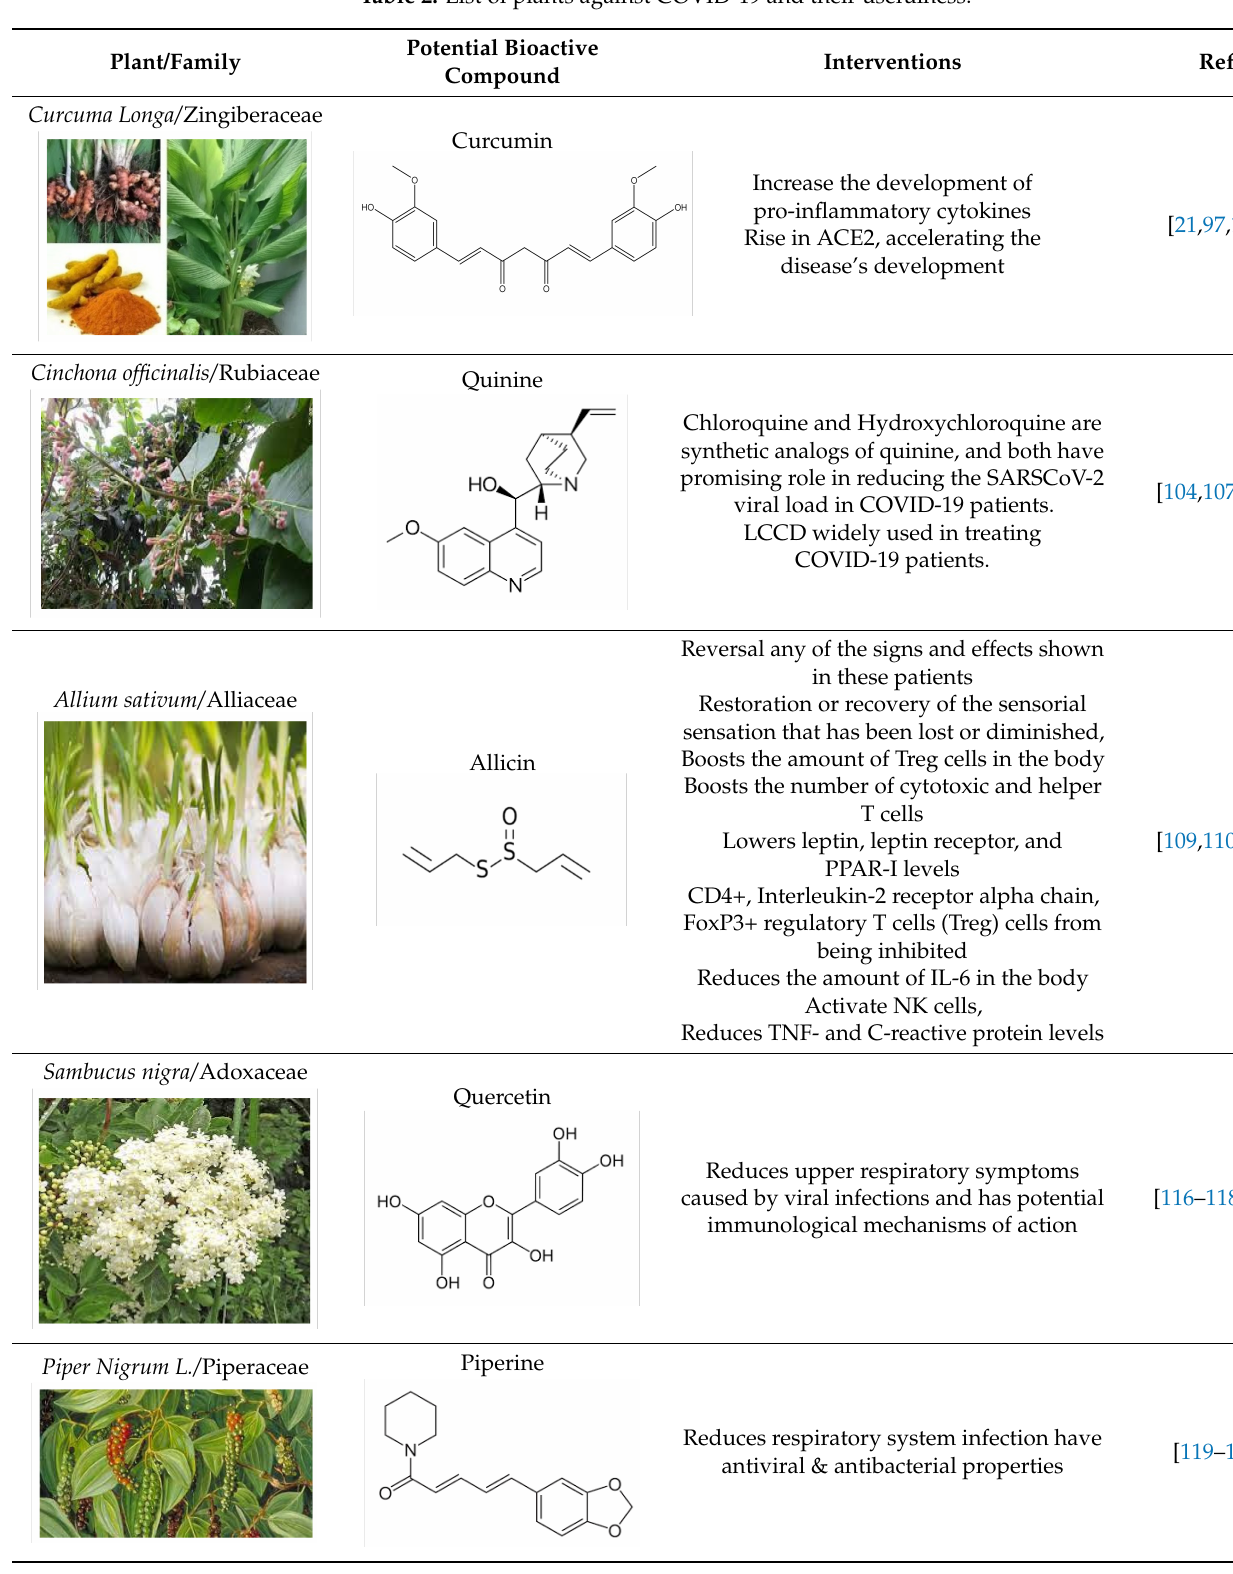
Table 2. List of plants against COVID-19 and their